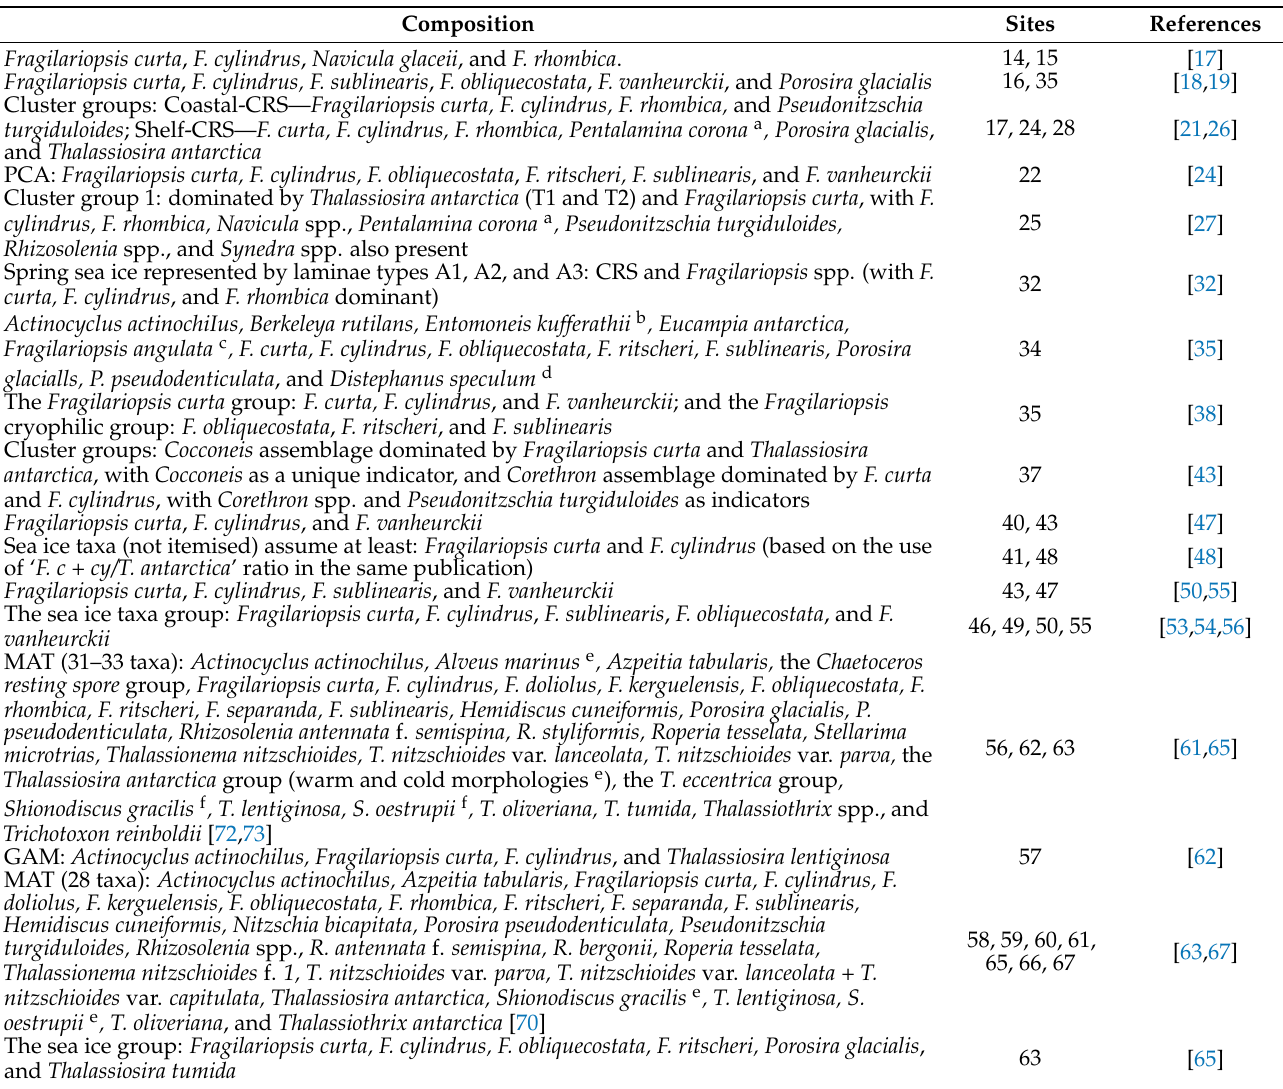
Table 5. Composition of proxy groups including Fragilariopsis curta